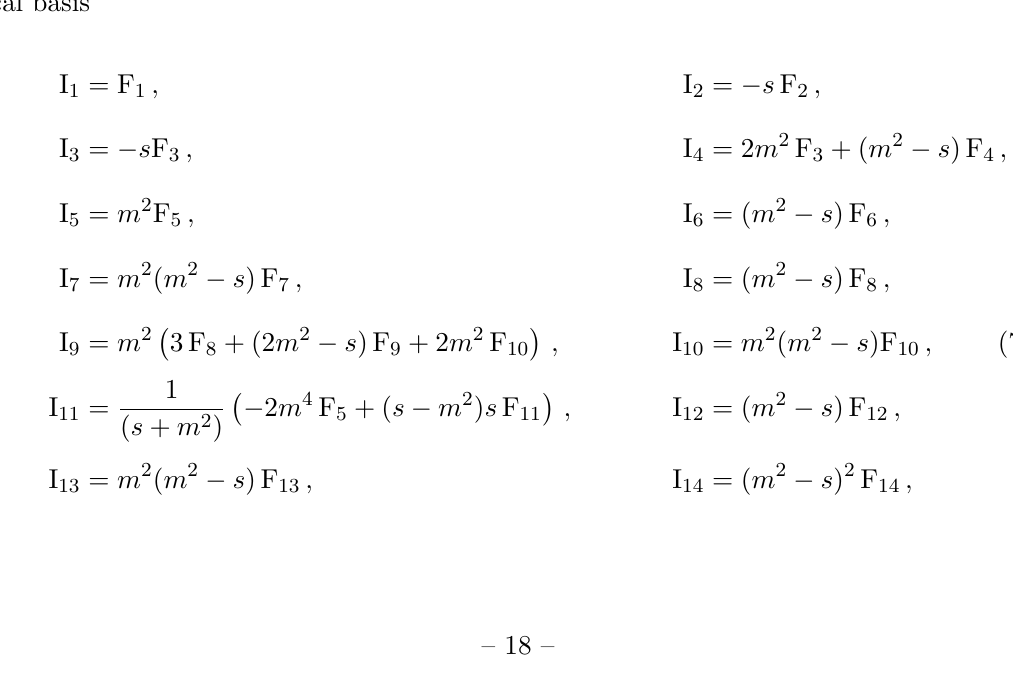
for the non-planar 1 ;:::; 14